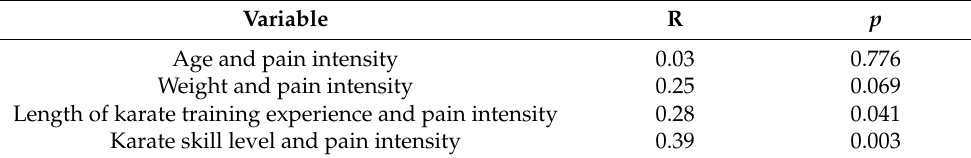
Table 6. Assessment of correlation with pain intensity.